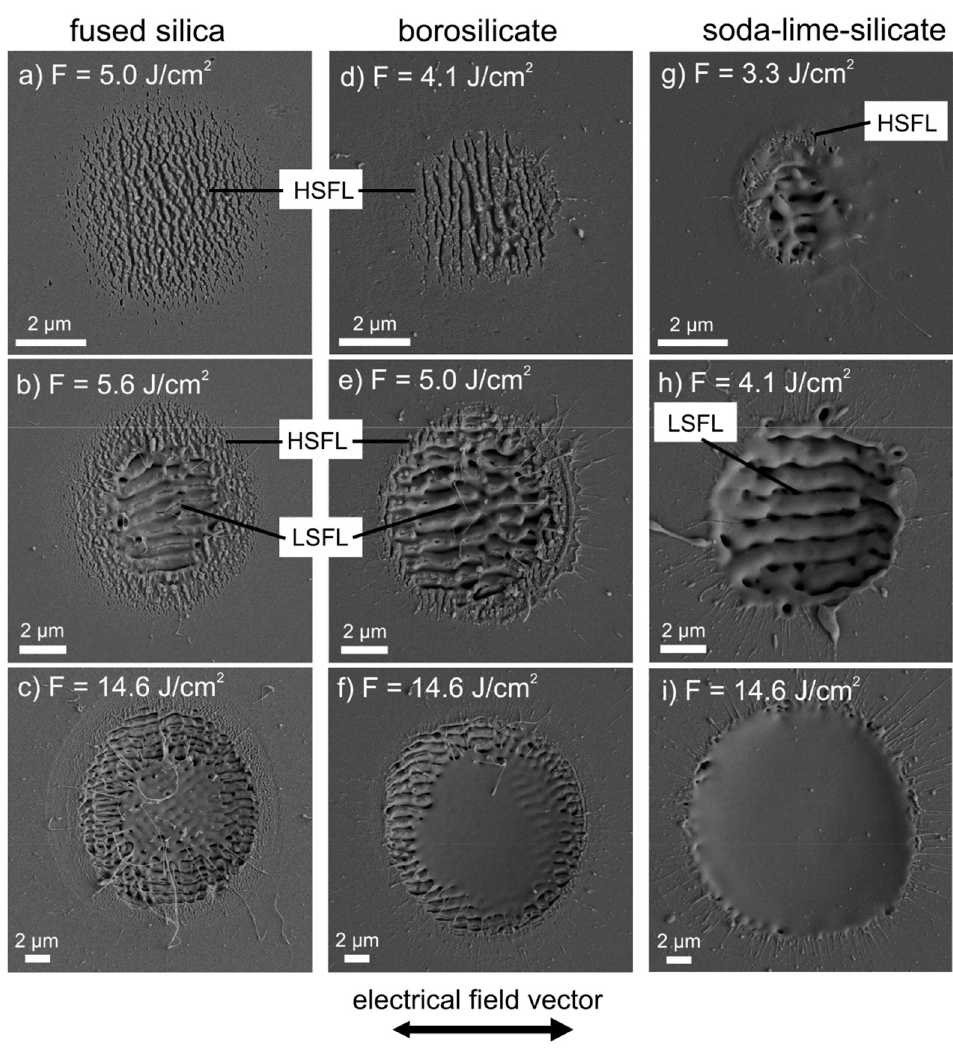
Figure 5. SEM micrographs of fused silica ( a – c ), borisilicate glass ( d – f ) and soda-lime-silicate glass ( g – i ) after irradiation with five laser pulses at different peak fluences. Reproduced with permission from Ref. [42]. Copyright 2017 under Creative Commons BY 4.0 license.